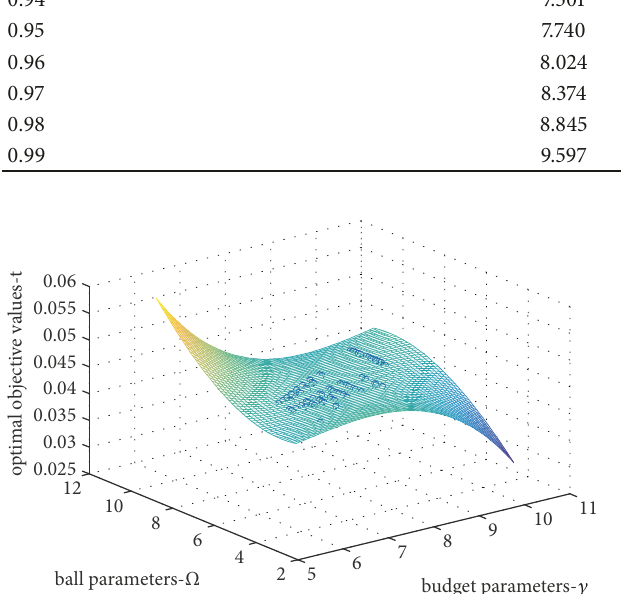
Figure 5: The optimal values under ball and budget perturbation